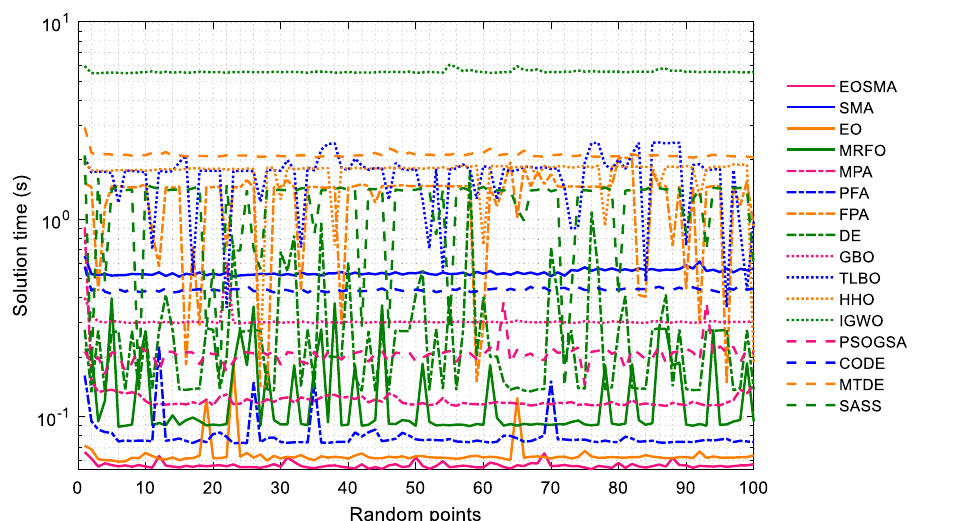
Figure 9. Solution time of comparison algorithms at randomly selected position